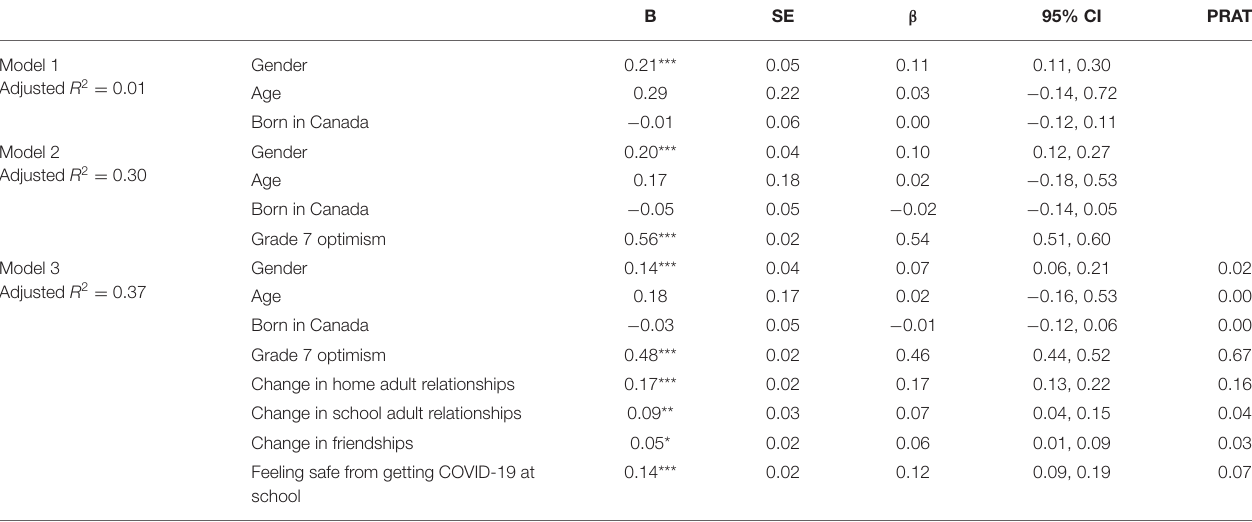
B SE β 95% CI PRATT